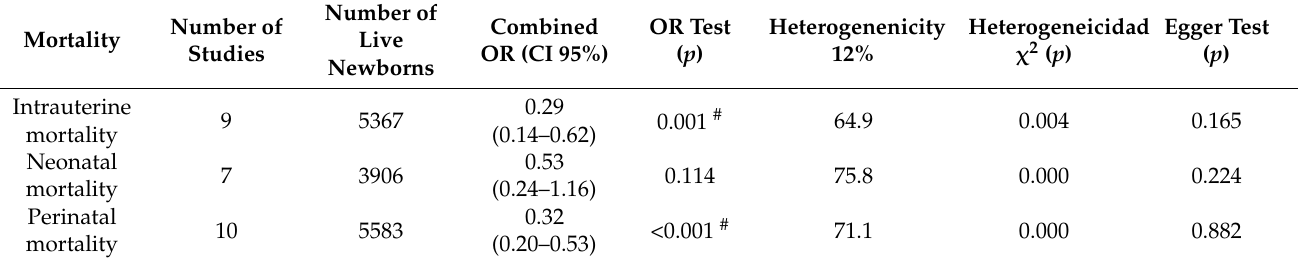
Table 9. Mortality results of the triplet pregnancies included in the meta-analysis according to